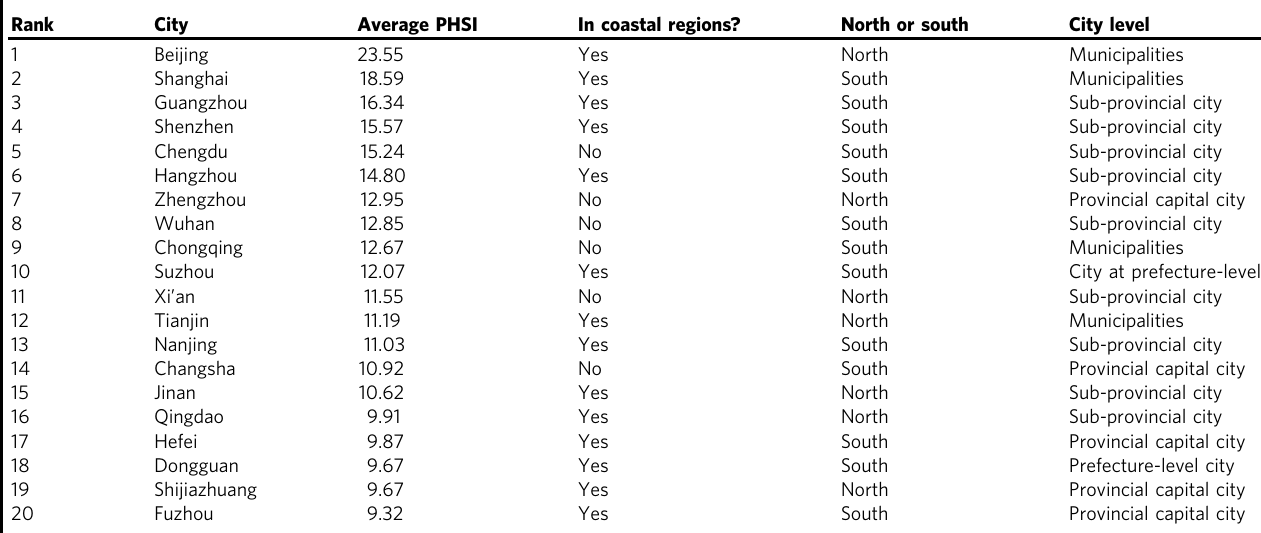
Table 3 Top 20 cities with the average PHSI.